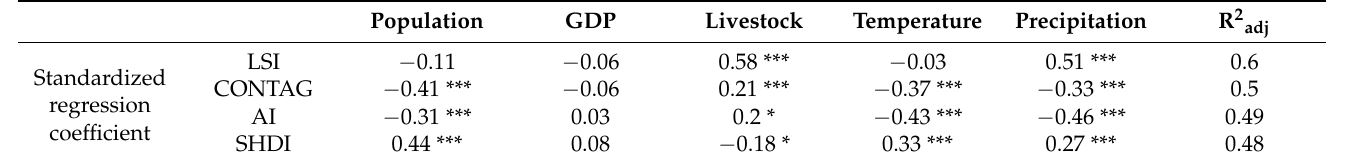
Table 4. Relationships between landscape metrics at the landscape level and the driving factors. Population GDP Livestock Temperature Precipitation R 2